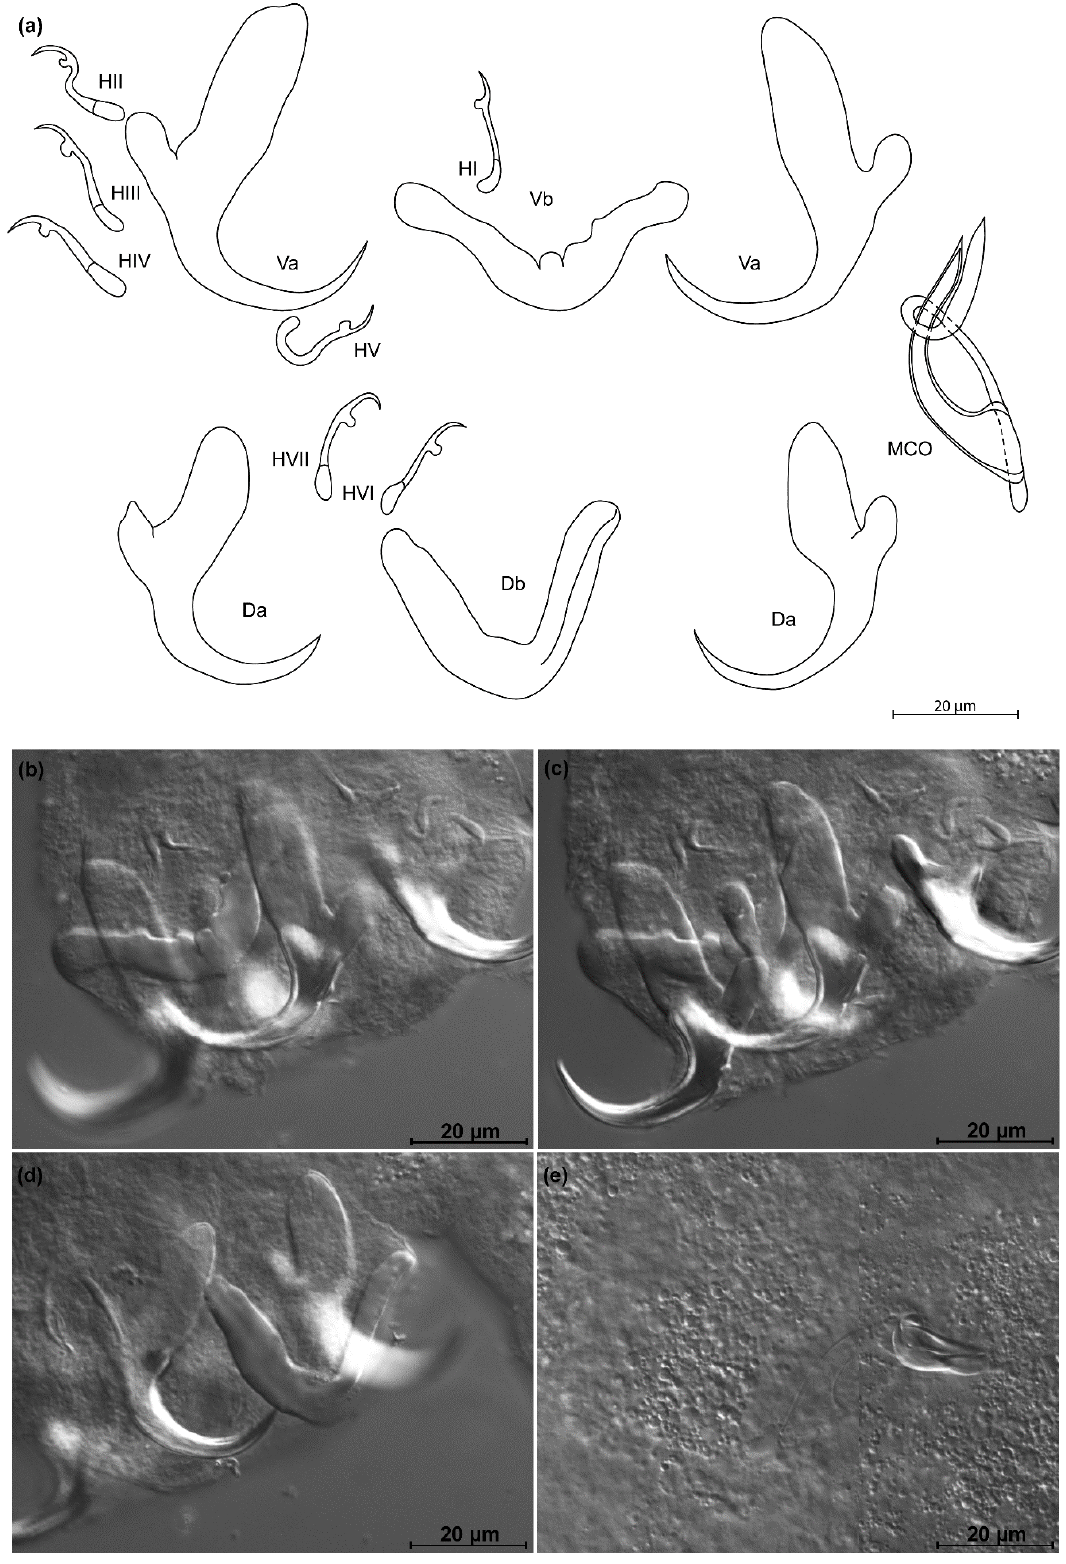
Figure 8. Kapentagyrus sefcae n. sp. (ex Odaxothrissa losera ). ( a ) Drawings of sclerotized structures, Va-ventral anchors, Da- dorsal anchors, Db-dorsal bar, Vb-ventral bar, H-hooks (pairs I to V—ventral; pairs VI, VII—dorsal), MCO-male copulatory organ. ( b ) Micrograph of ventral bar. ( c ) Micrograph of ventral anchors. ( d ) Micrograph of dorsal anchors and dorsal bar. ( e ) Micrograph of MCO.